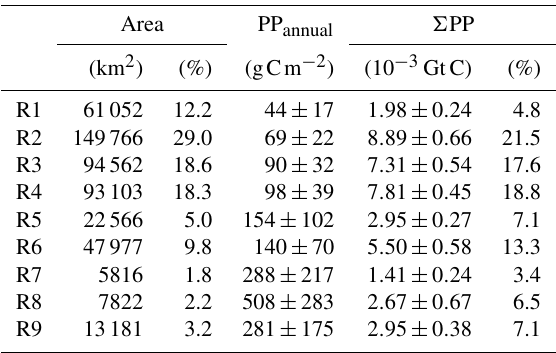
Table 4. Extension and primary production for each of the SOM- defined regions (R1 and R9). Mean annual PP is estimated by aver- aging mean daily PP and then multiplying it by the number of days of the year, i.e., 365.